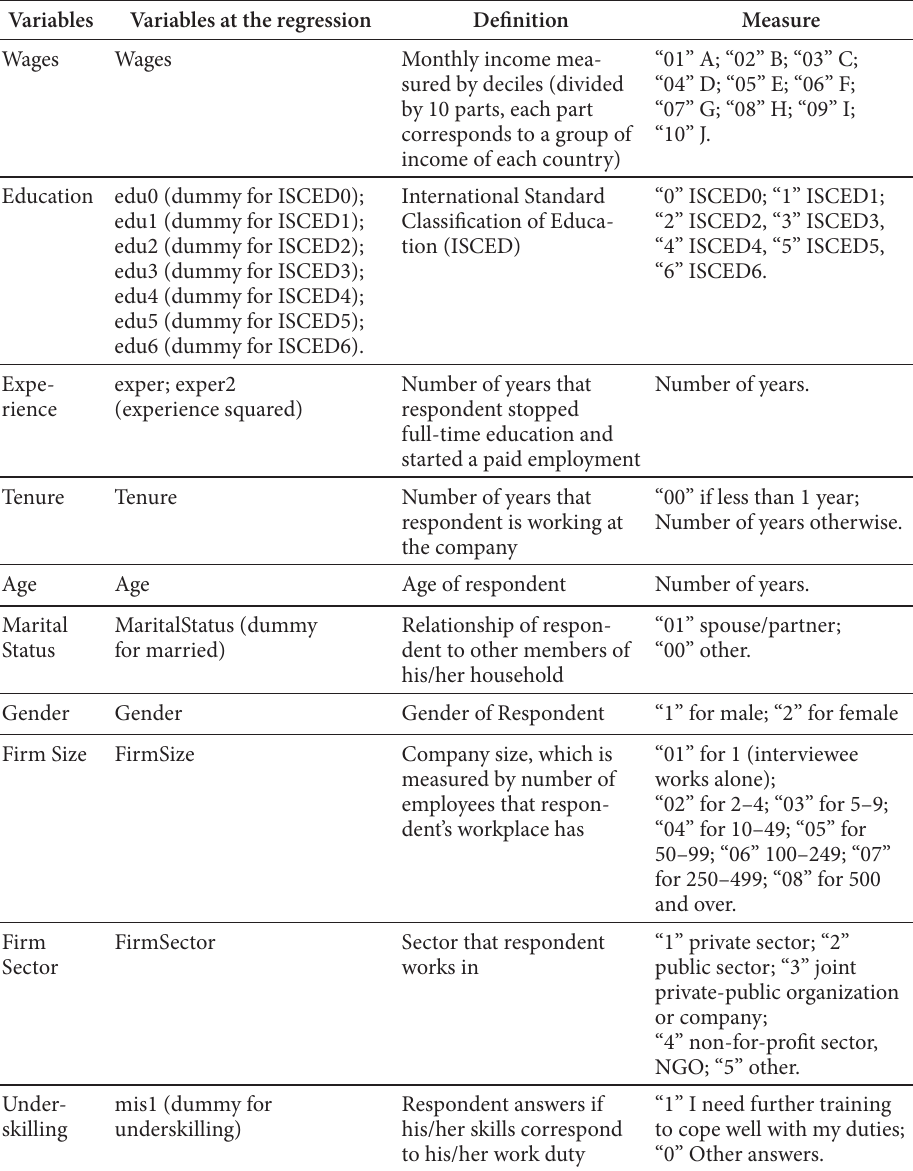
Table 1. Variables and